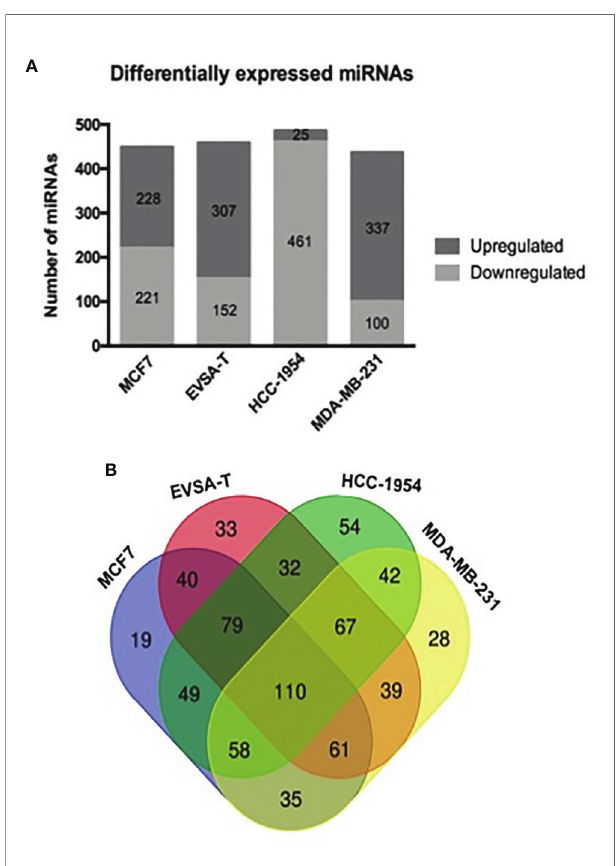
FIGURE 1 | Differentially expressed miRNAs in human breast cancer cell lines. (A) Number of miRNAs obtained as differentially expressed by RT-qPCR analysis of 1008 miRNA levels from miRNome PCR array. SnoRNAs/snRNAs were used as housekeeping genes for normalization. Positive and negative controls were also evaluated in the array. Quanti fi cation was performed by the DD CT method. The results were normalized relative to the HMEC cell line. (B) A Venn diagram drafted from http://bioinformatics.psb.ugent.be/webtools/ Venn, showing the total number and overlapping miRNAs identi fi ed as differentially expressed by quantitative PCR array from the following breast cancer cell lines: MCF7, EVSA-T, HCC-1954 and MDA-MB-231 (normalized relative to the HMEC cell line).